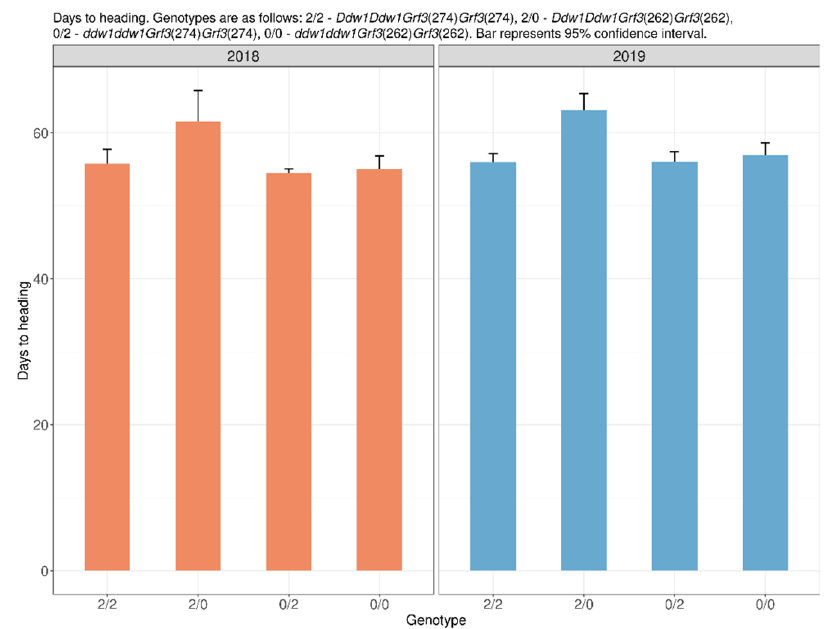
Figure 3. The effect of the allelic state of DDW1 and Grf3 on period duration from sowing to heading.